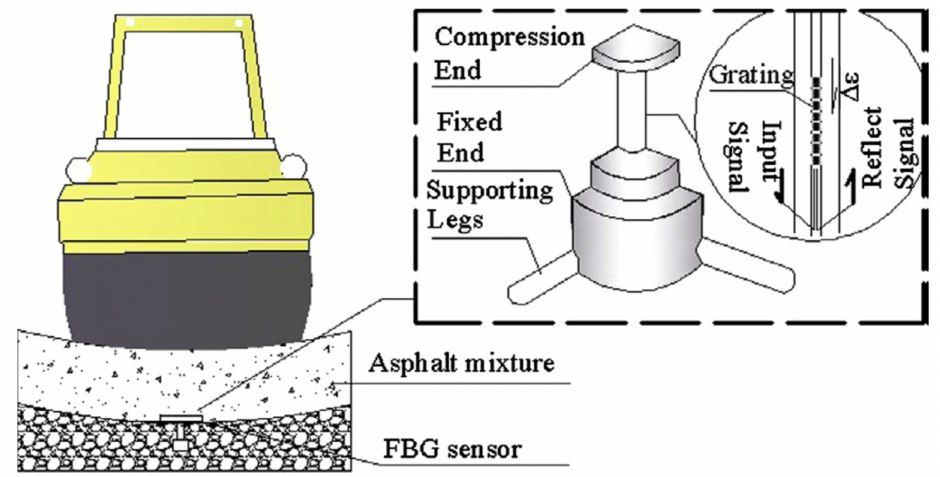
Figure 9. FBG sensor embedded in asphalt pavement